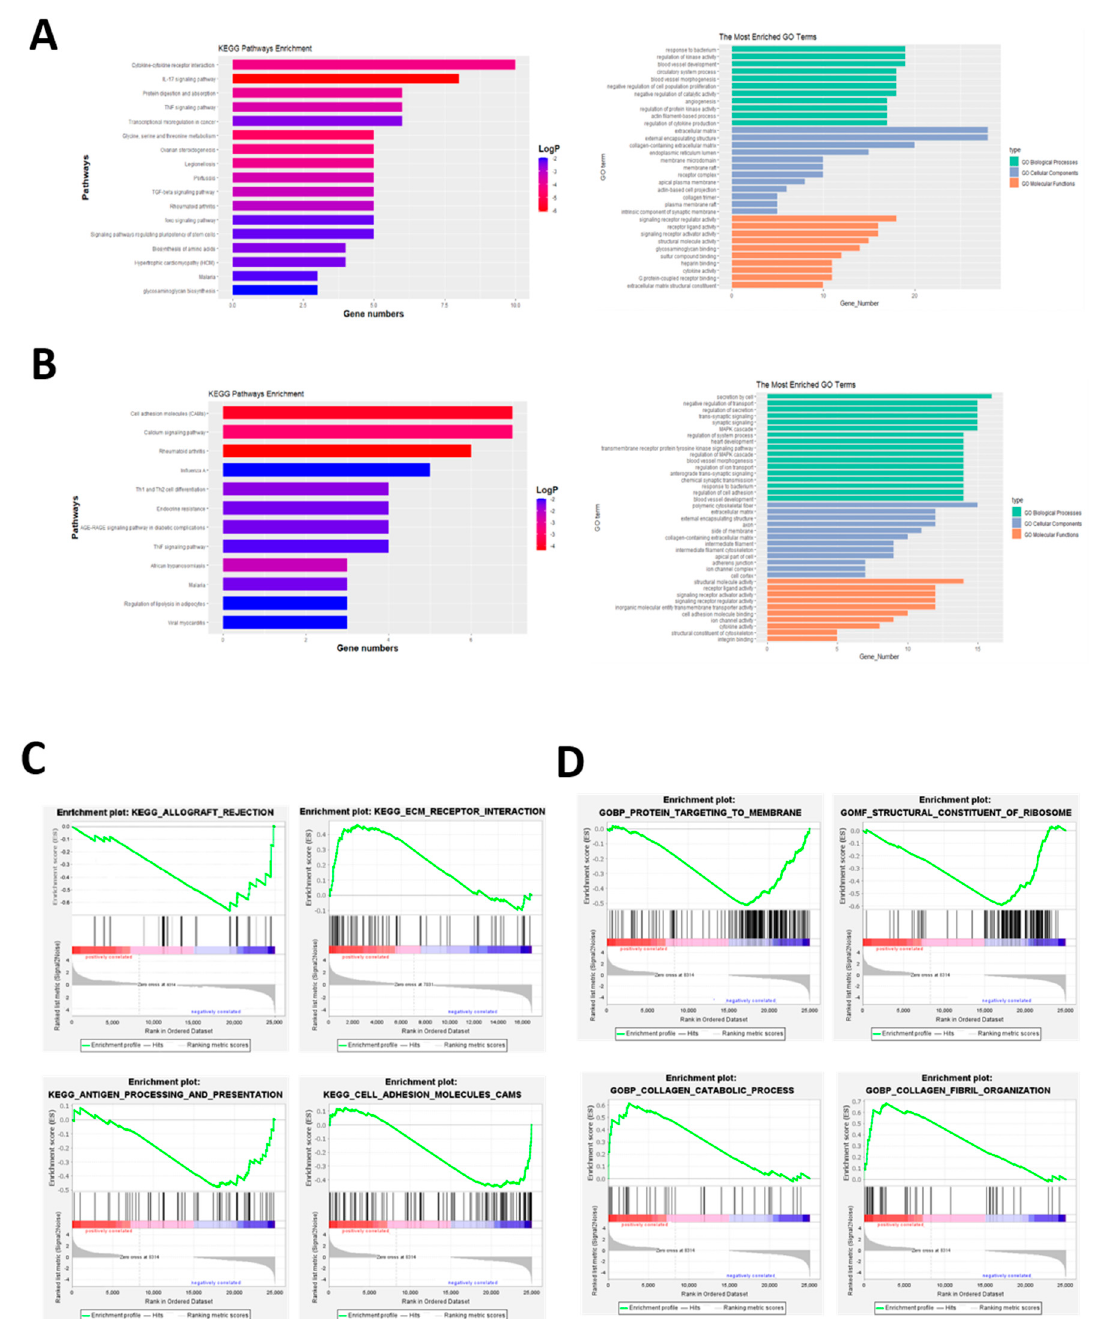
Figure 3. RNA-seq differential gene enrichment analysis identified pathways significantly altered by NR2F2. ( A ) KEGG and GO enrichment pathways of up-regulated genes. ( B ) KEGG and GO enrichment pathways of down-regulated genes. ( C ) KEGG analysis of GSEA. ( D ) GO analysis of GSEA.